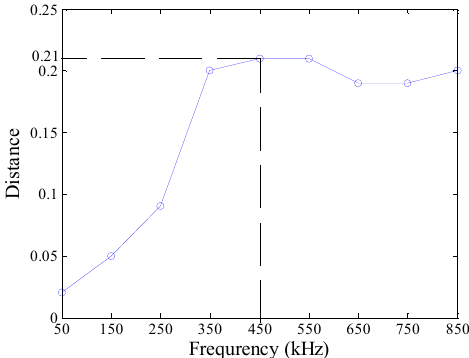
Figure 6. Distance between the defect features.